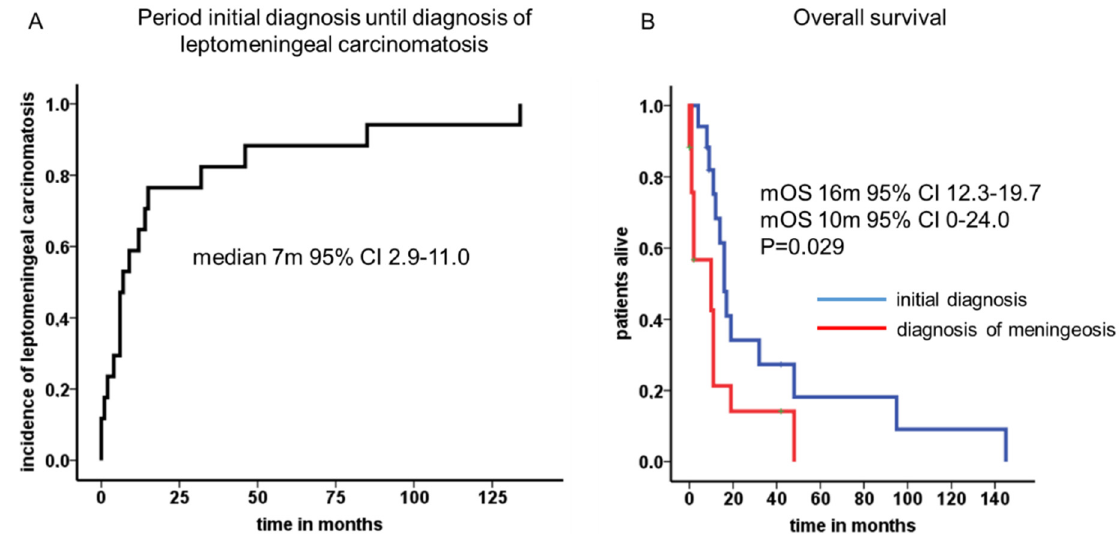
Figure 1. Period of initial diagnosis until diagnosis of leptomeningeal carcinomatosis and median overall survival times. A median latency of 7 months (95% CI 2.9–11.0) was calculated from initial diagnosis to leptomeningeal manifestation ( A ). The cumulative median overall survival reached 16 months (95% CI 12.3–19.7), whereas the median overall survival was 10 months (95% CI 0–24.0) after leptomeningeal carcinomatosis was diagnosed ( B ).